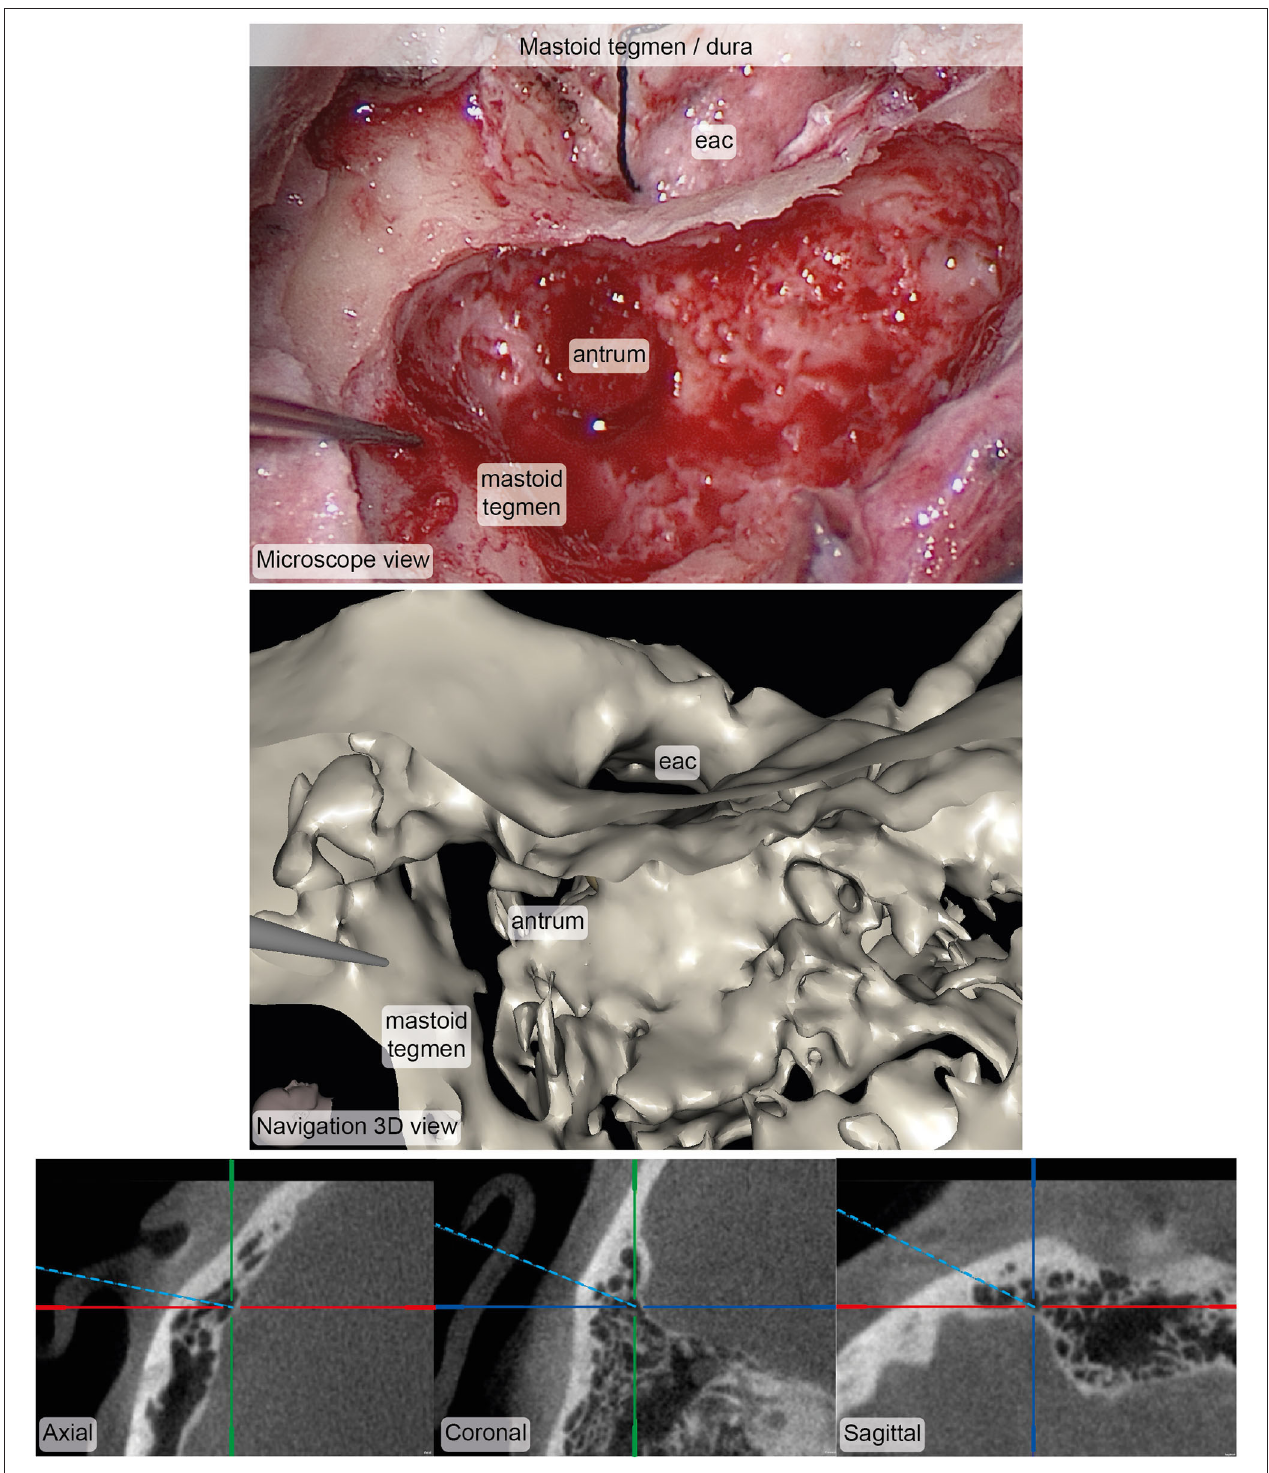
FIGURE 7 | Example of corresponding images from the microscope (top) and the stereotactic image-guidance system (bottom) depicting the pointer pose on the bone of the mastoid tegmen covering the dura. The image pair was rated in terms of accuracy (median: 4, interquartile range: 3.5–4.5, N = 5) and usefulness (median: 4, interquartile range: 4–4.5, N = 5). Inspection of and zooming into the individual MPR and 3D viewer panels were possible during rating. eac, external auditory canal.